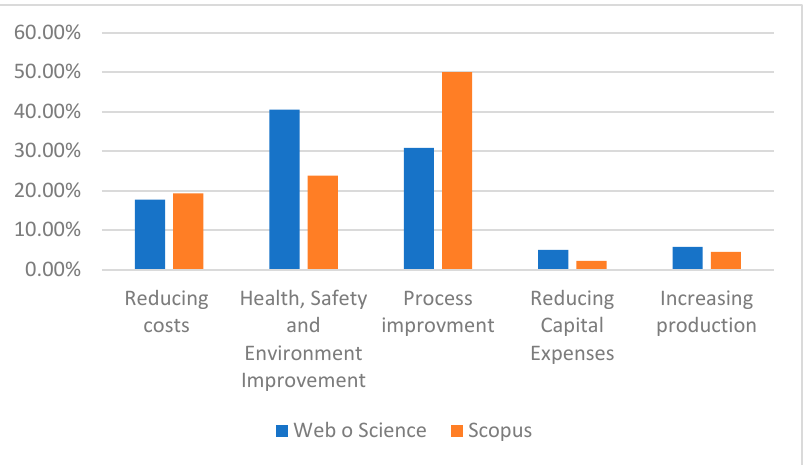
Figure 9. Impact of digitalization in energy production, distribution, and consumption in the Web of Science and Scopus databases for the period 2012–2022.